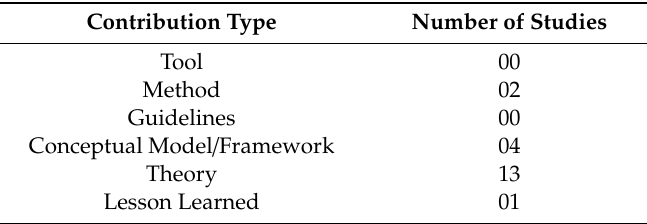
Table 7. Number of studies classified on basis of contribution type.